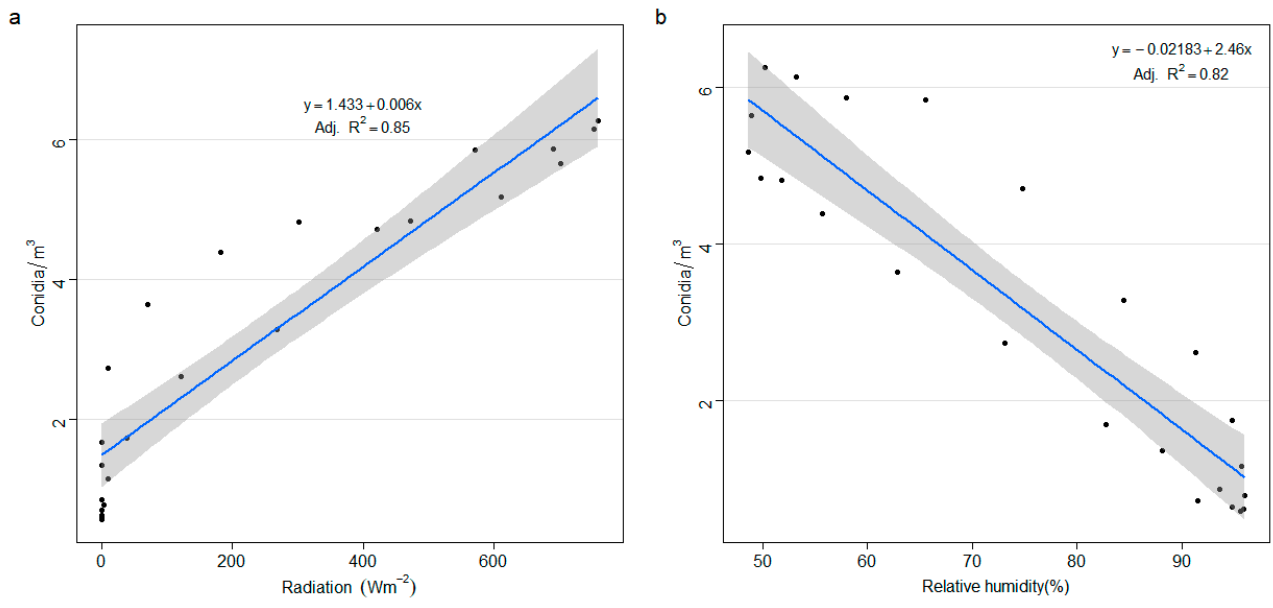
Figure 6. Linear regression graphs with confidence bounds of solar radiation (Radiation) ( a ) or Relative humidity ( b ) and conidia. The grey area surrounding the regression line represents the 95% confidence interval. Table 1. Coefficients of a combined linear regression analysis in which the weather variables that had the strongest effect on conidia were used to predict conidia concentration according to the hour in the day. Abbreviations are as follows: RH (relative humidity); Rad (solar radiation); RH: Rad (interactions between relative humidity and solar radiation).